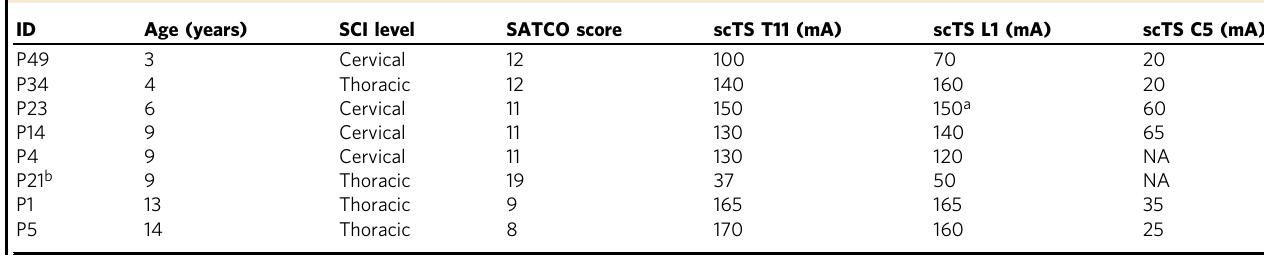
Table 1 Participant demographics and stimulation